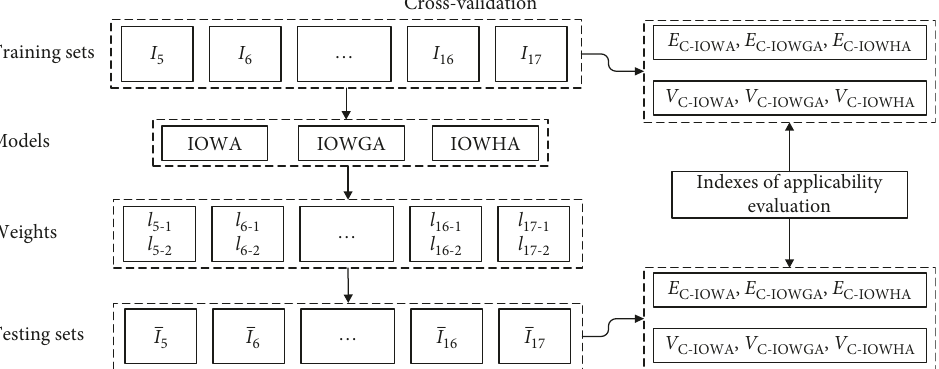
Figure 12: Flowchart for